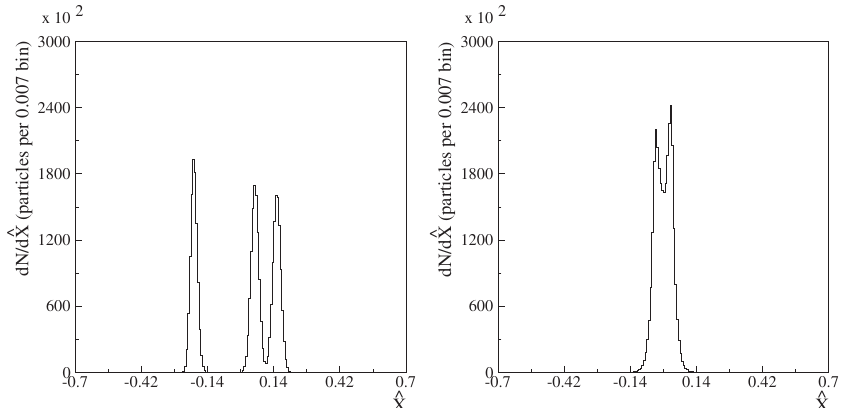
FIG. 5. Projected distribution functions for the three-turn injection after the injection (left) and at the end of the merging process (right). The two islands centered at the origin with opposite angles are projected onto the central peak visible in the initial distribution function.